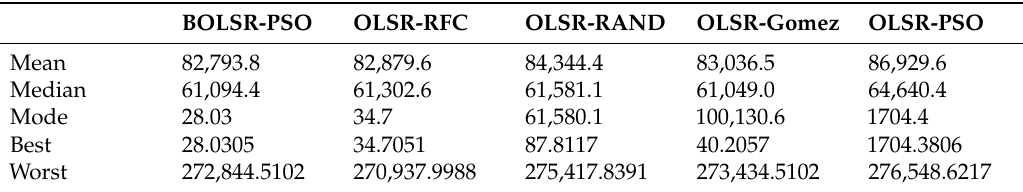
Table 5. Statistical Result of Packet loss Performance